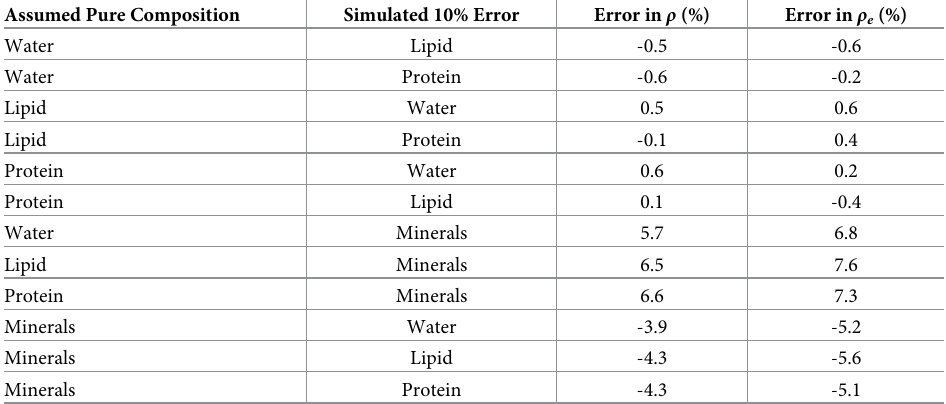
Table 3. Sensitivity analysis of the HU and molecular composition to ρ and ρ e conversion process for kVCT using α i values determined by method 2 (CT calibration phantom).